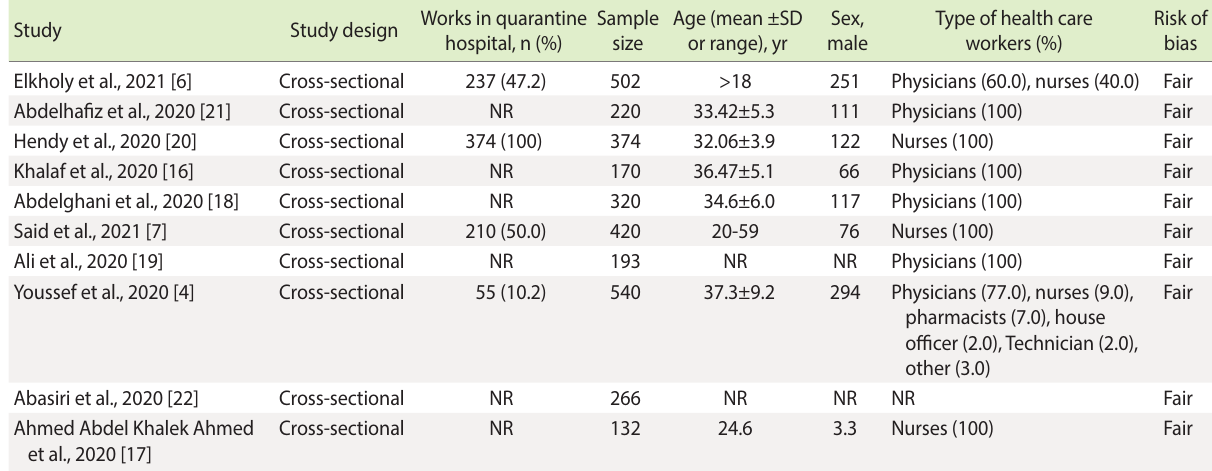
Figure 1. Flow diagram representing the process of the review. ISI, Web of Science; NYAM, New York Academy of Medicine; SIGLE, System for Information on Grey Literature in Europe. 1 Includes irrelevant articles, no reliable or overlapped data. 2 Includes conference papers, reviews, books, editorials, letters, oral presentation, correspondence, communications and Table 1. Characteristics of the included studies